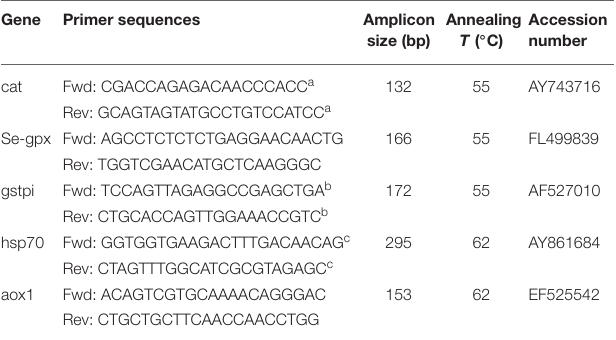
TABLE 1 | Primer pair sequences, amplicon size, annealing temperatures, and Genbank accession numbers of genes analyzed in quantitative PCR in the digestive gland of